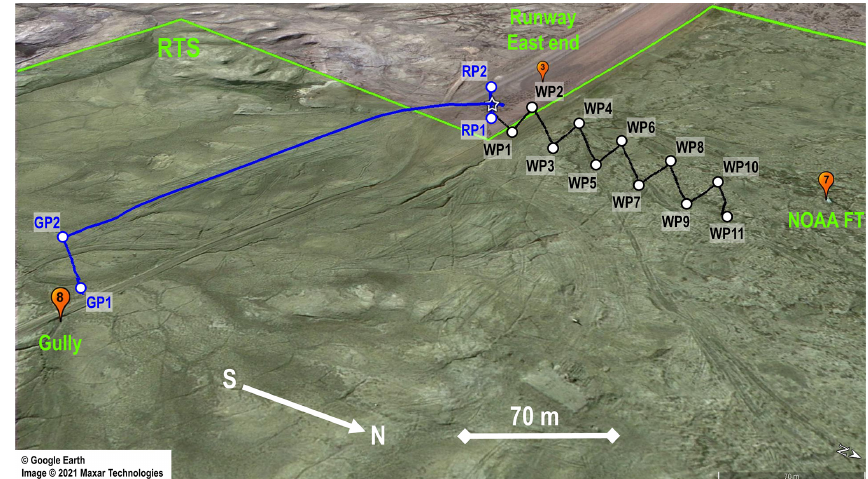
Figure 7. M210 RTK flux tower (black solid line) and gully versus runway (blue solid line) flight trajectories at the Runway Test Site (RTS) on 6 March 2020. Pins in the figure indicate the locations of the east side of the Eureka Aerodrome runway – no. 3, NOAA flux tower – no. 7, and gully – no. 8. Typical waypoints of the drone flights near the FT are marked with red open circles (WP1–WP11). Typical waypoints of the gully versus runway drone flights are marked with blue open circles (RP1–RP2 – runway temperature profile, GP1–GP2 – gully temperature profile). Table 1. M210 RTK flights in